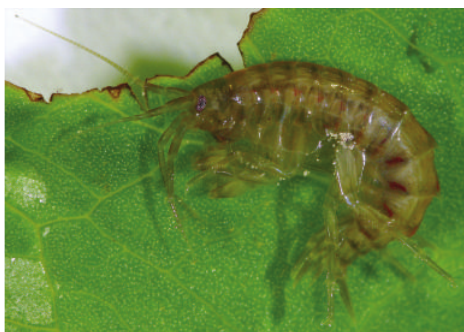
Figure 1: Macrophotographic image of a living gammaridean, Gammarus roeselii . An additional Raynox M-150 macroscopic lens was mounted on a Panasonic FZ-50 digital camera. Illumination with two synchronized Nikon SB-20